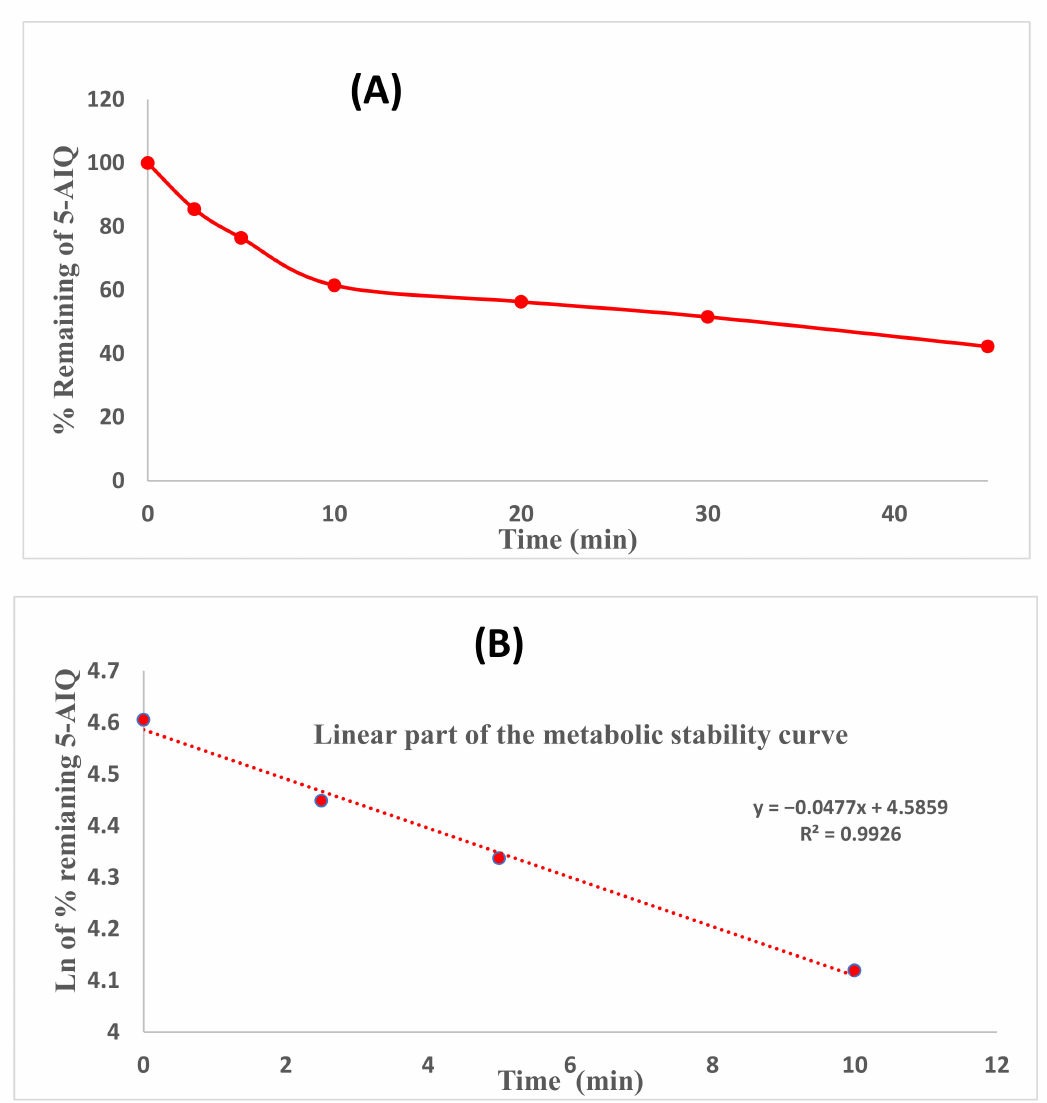
Figure 4. The metabolic stability curve of 5 − AIQ in HLMs ( A ) and the regression equation of the linear part of the curve ( B